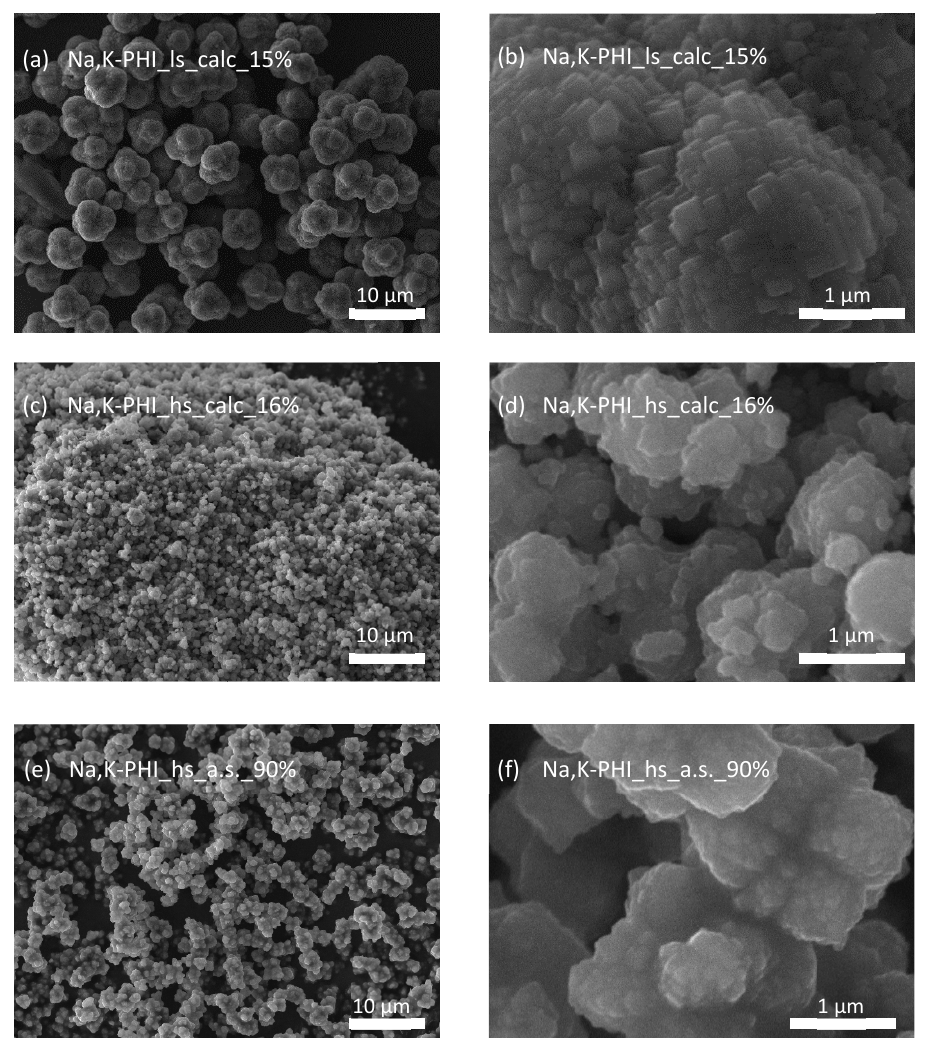
Figure 5. SEM pictures of the zeolites to see the morphology. (a,b) Na,K-PHI_ls_calc_15%; (c,d) Na,K-PHI_hs_calc_16%; (e,f) Na,K-PHI_hs_a.s._90%.